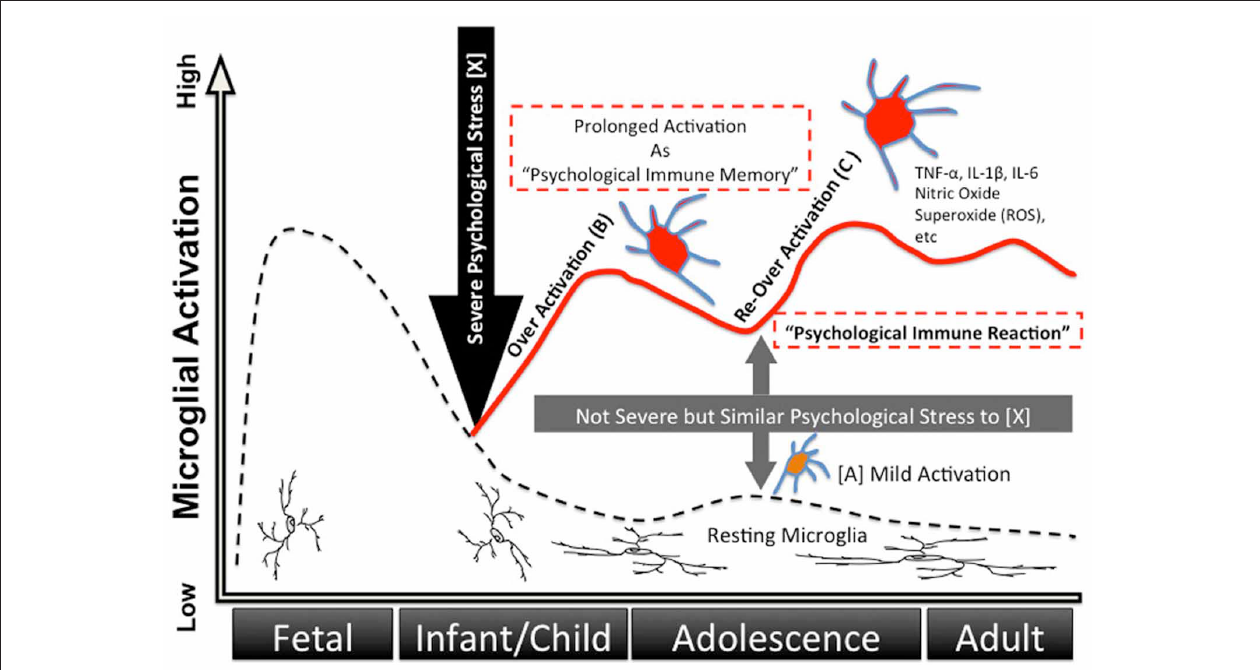
FIGURE 3 | Developing process of “psychological immune memory/reaction” via microglia. Microglia have proven to have direct connections with neuronal synapses, and external stress activates microglia via neuronal stimulus. Not only physical stress but also psychological stress activates microglia in animal models. Herein we propose a possible process of microglia activation as “psychological immune memory” during human life. (A) Normal daily psychological stress (not extreme stress) moderately and temporarily activates microglia via neuronal stimulus (A) . (B) Severe psychological stress (e.g., trauma) over-activates microglia via nervous excitement (B) , which induces a storm of inflammatory cytokines and free radicals in the brain, thus resulting in abnormal behaviors and strong emotional reactions. In addition, this storm results in damaging neuron-glial networks and the subsequent rebuilding of novel neuro-glial networks. This